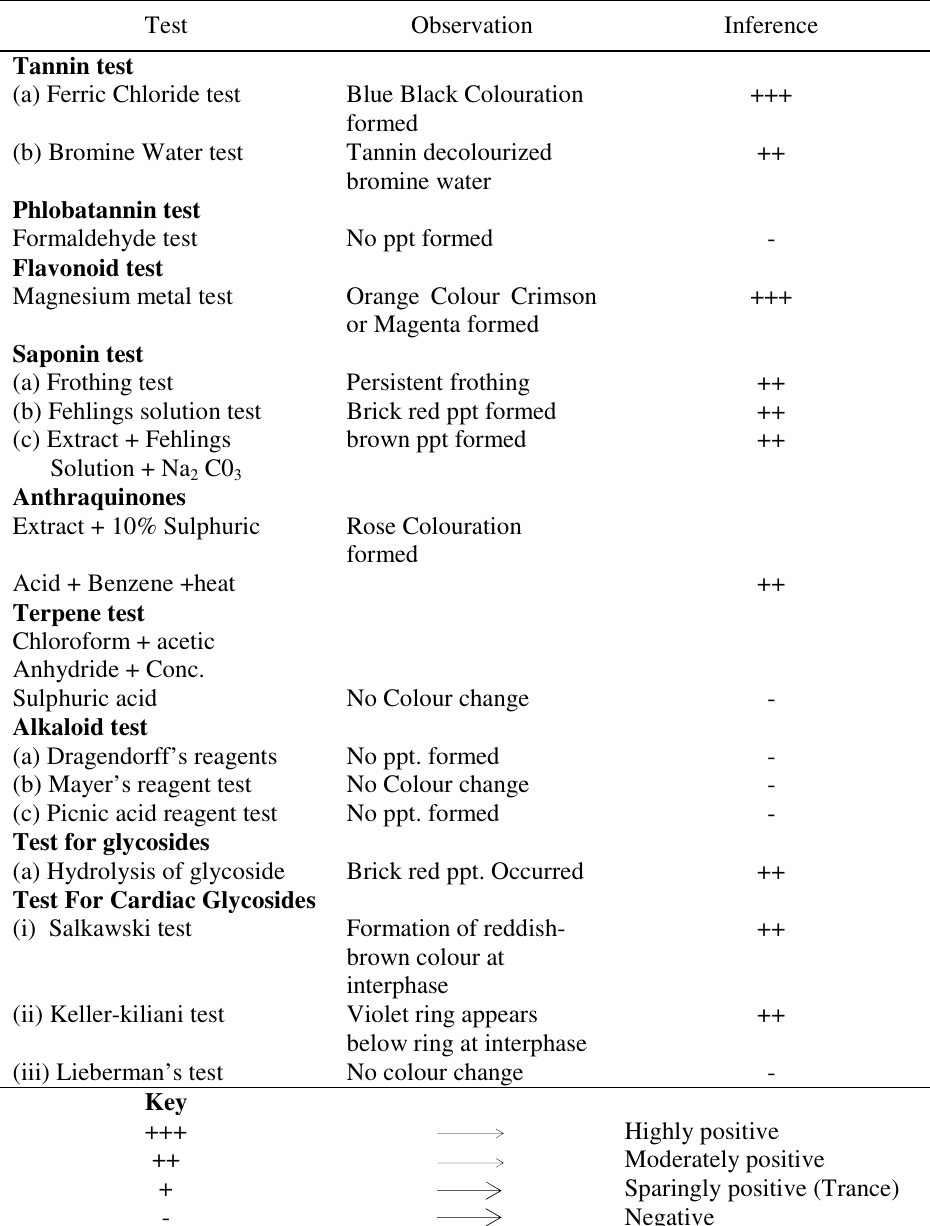
Table 1. Phytochemical screening of Alchornea cordifolia